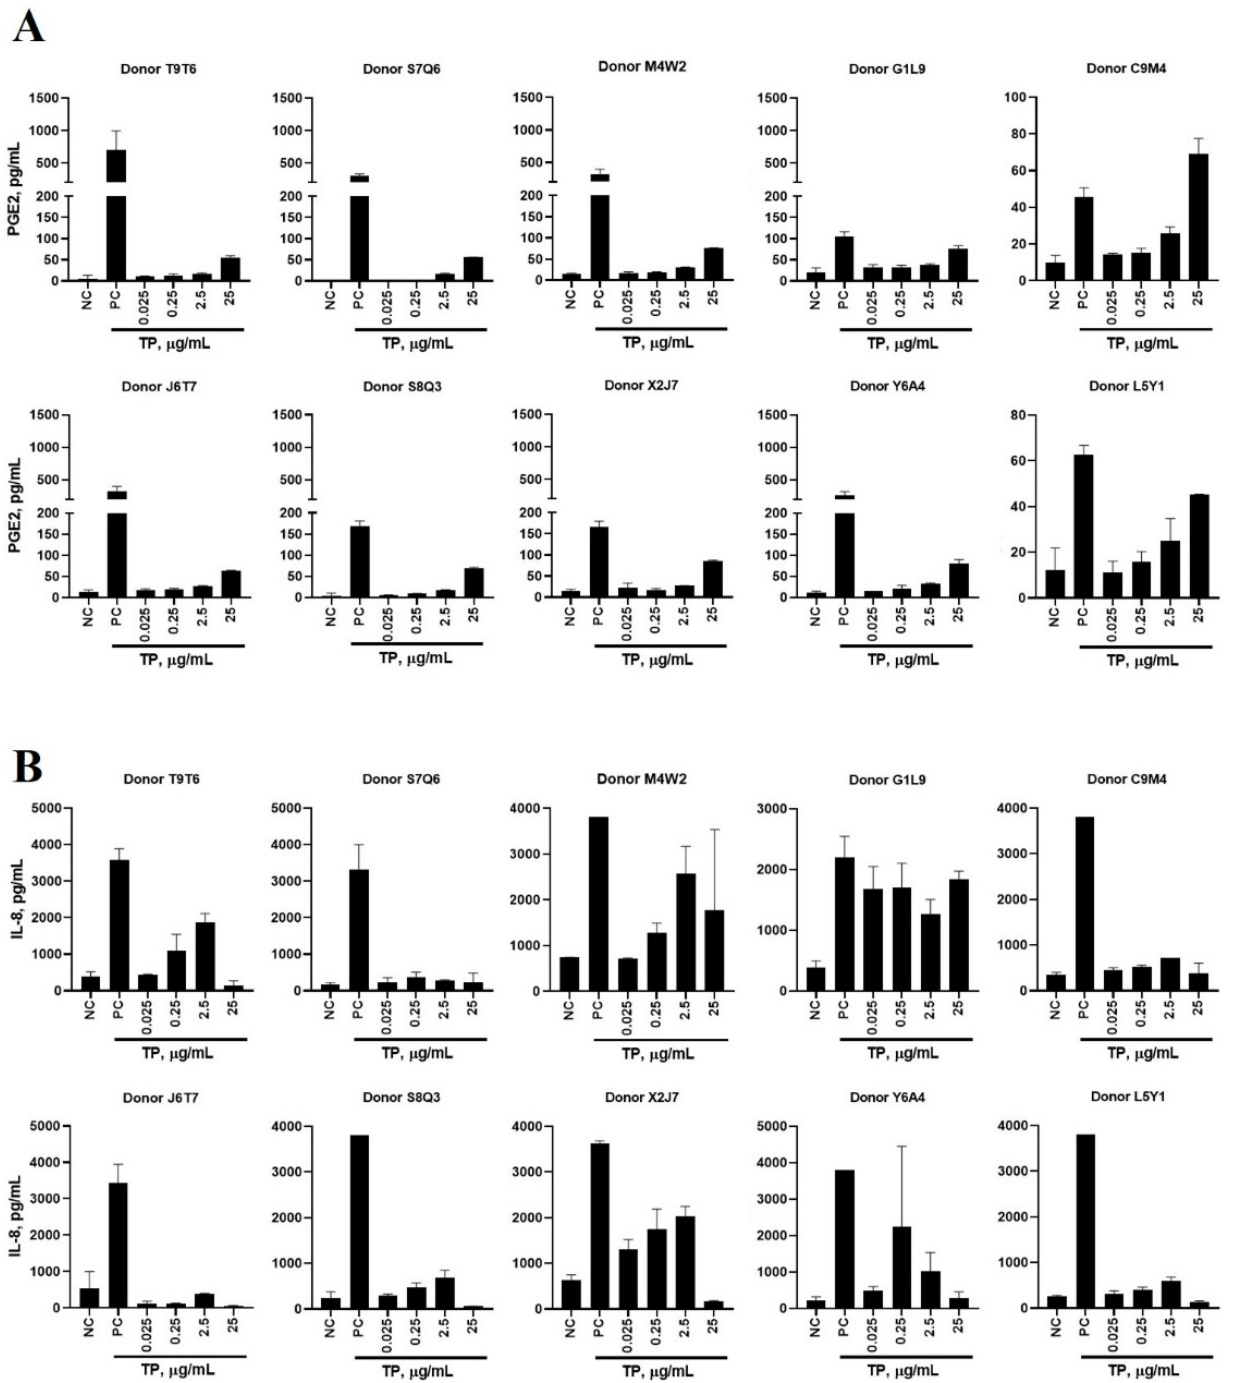
Figure 1. A 16-plex Induction of Prostaglandin-E 2 and Interleukin-8 by Teriparatide. PBMCs from 10 healthy human donors were treated with 0.025, 0.25, 2.5, and 25 µ g/mL teriparatide (TP), compared to a PBS negative control (NC) and LPS/PHA-M/ODN positive control (PC) for 24 h. Supernatants were analyzed for the presence of ( A ) PGE-2 or ( B ) IL-8 by 16-plex multiplex ELISA. Each bar shows mean and standard deviation (N = 2).